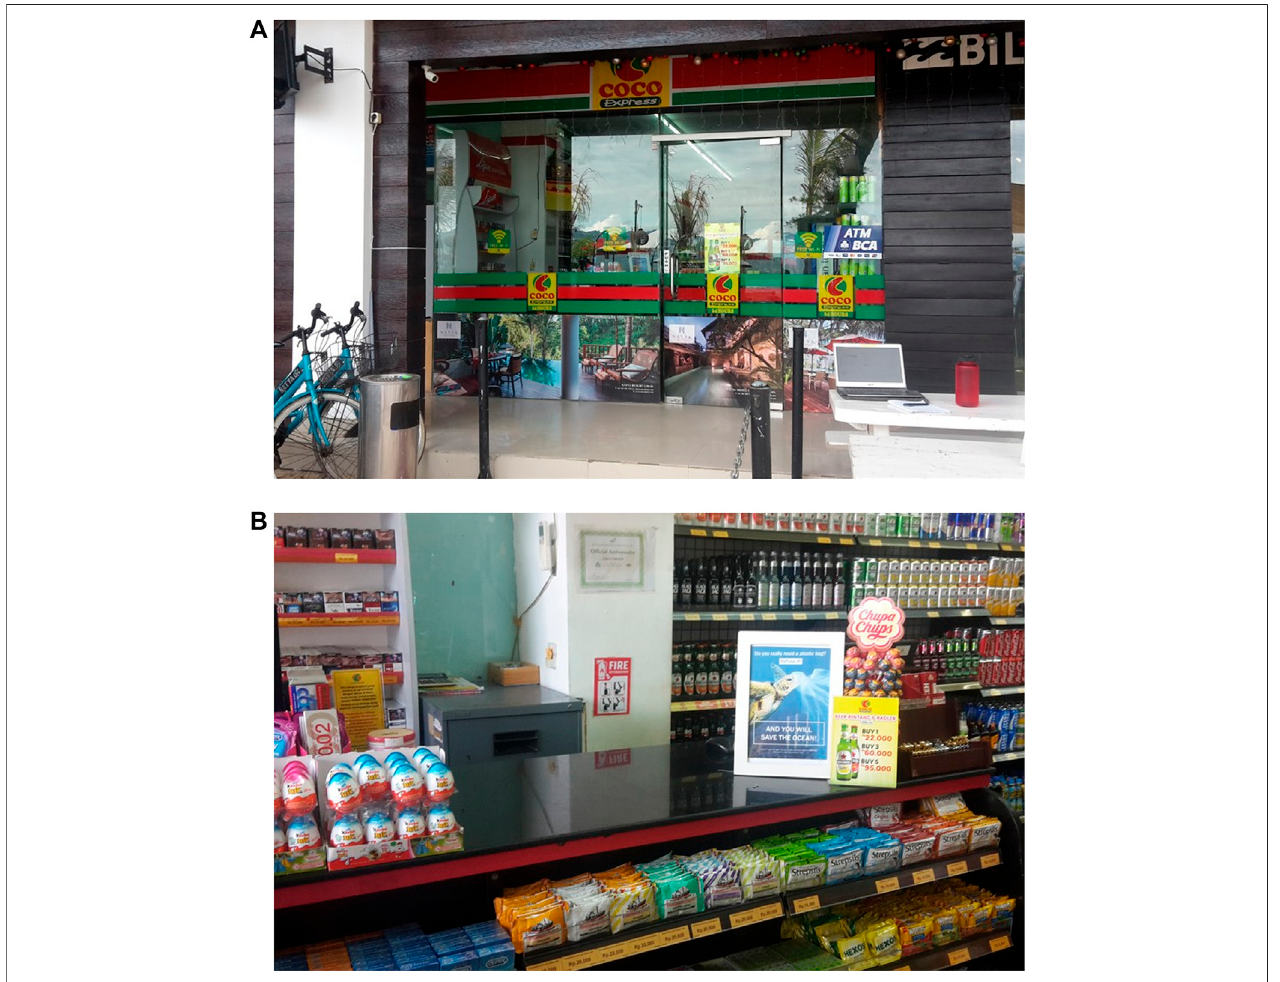
FIGURE 1 | (A) (top): The seating area in front of the Coco Express store with window fronts. (B) (bottom): Positive message sign on the counter of the Coco Express store.